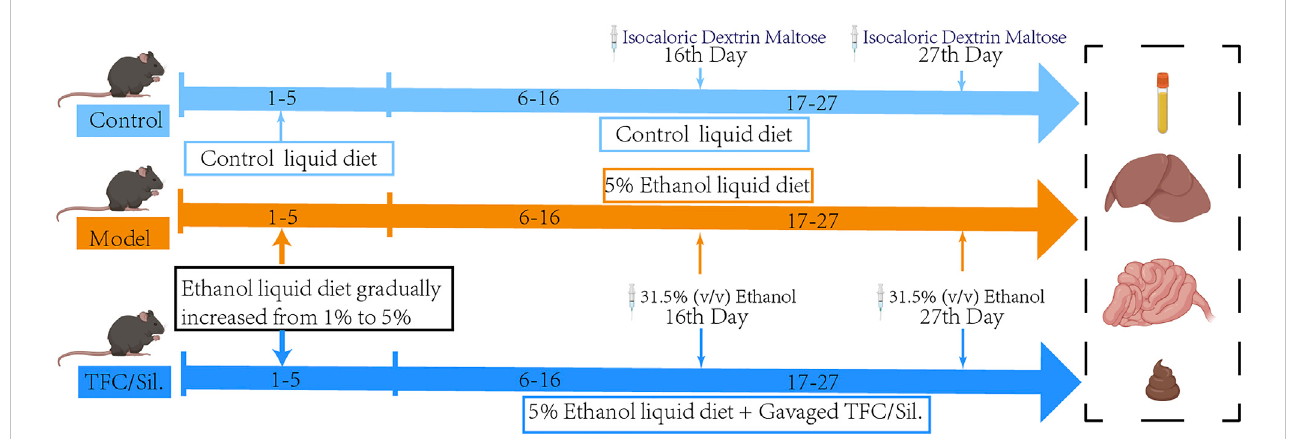
FIGURE 1 Illustration summarizes the experimental protocol. Liquid feed acclimatisation was carried out on days 1 – 5, with increasing alcohol content in the alcoholic feed feeding group. At the end of acclimatisation, the model group, each administration group was given a daily liquid feed with 5%alcohol content and gavaged with 31.5% (v/v) ethanol on days 16 and 27, during which time different doses of Sil. And TFC were gavaged